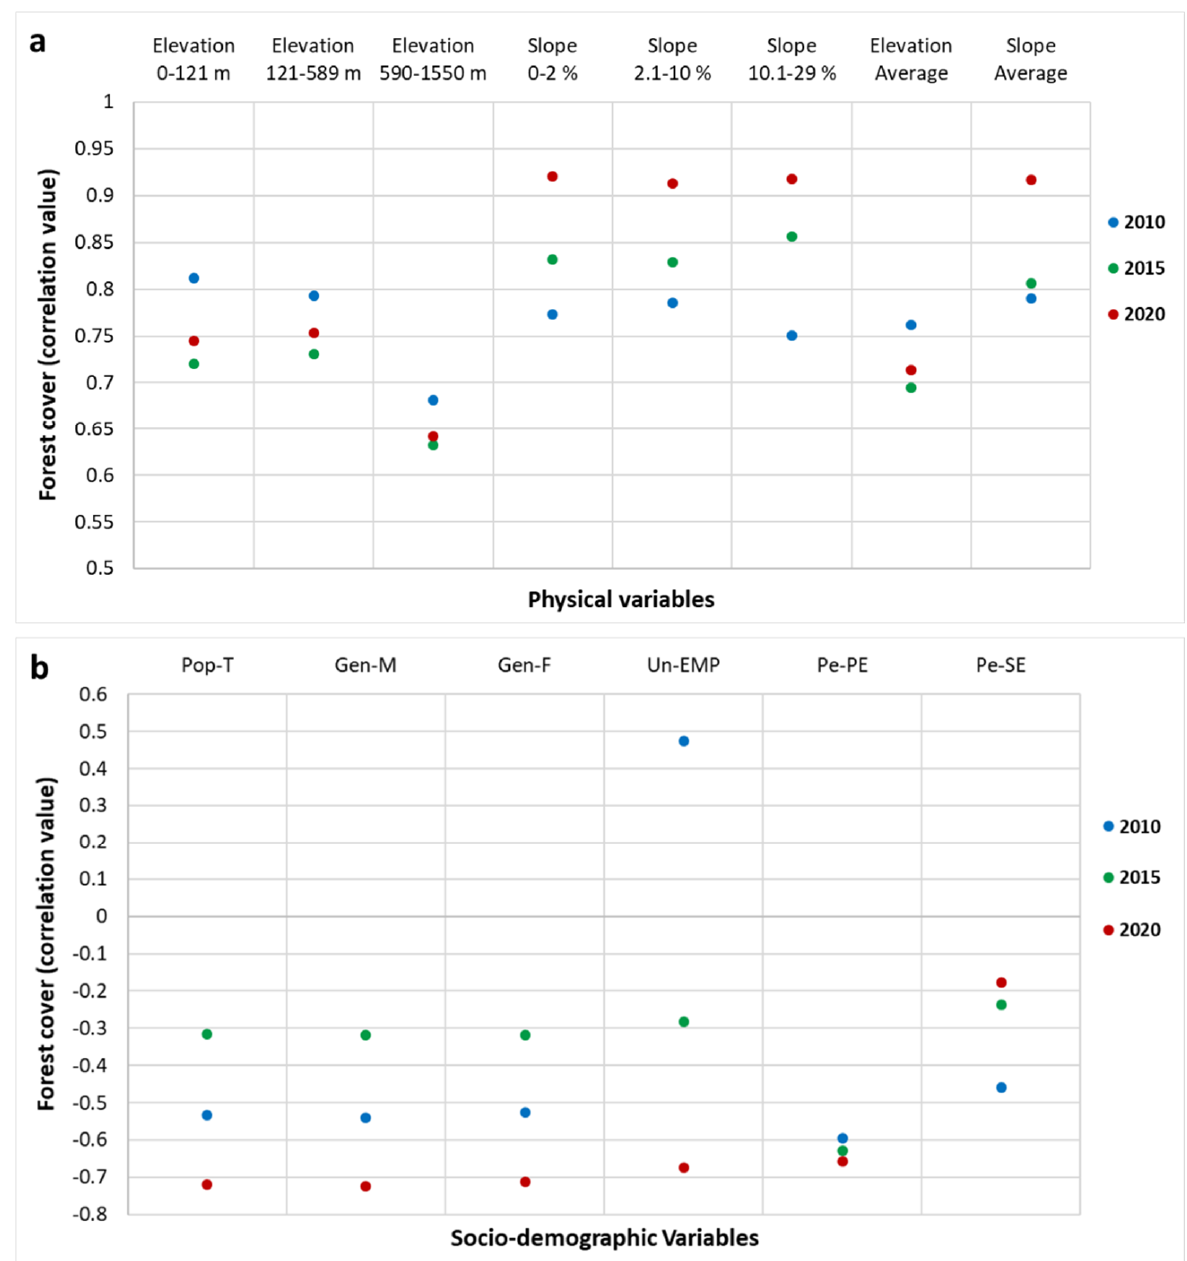
Figure 8. The relationship between forest cover extent and physical variables ( a ) and socio-demographic variables ( b ) between 2010 and 2020 in the Syrian coast region. Where Pop-T is total population, Gen-M is males, Gen-F is females, Un-EMP is unemployed, Pe-PE is primary education, and Pe-SE is secondary education.